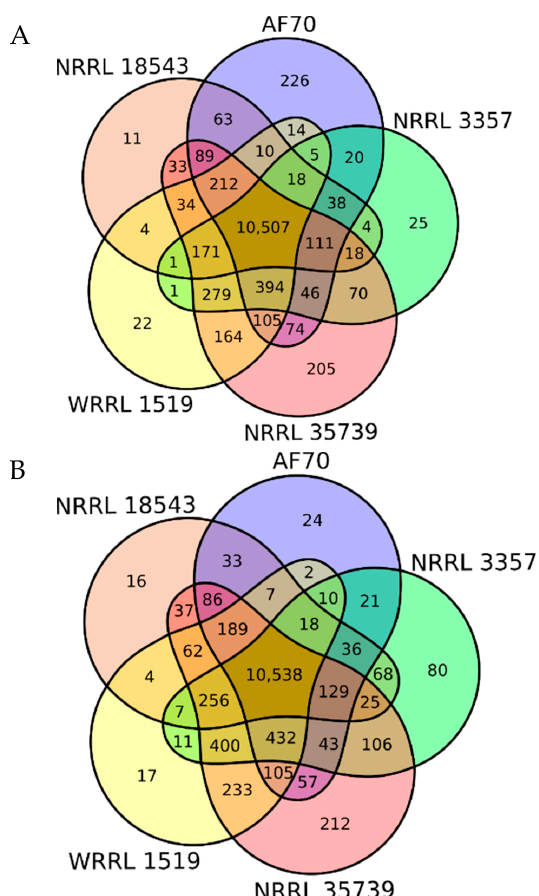
Figure 4. Venn diagrams of commonly expressed genes for selected A. flavus strains . Genes that had FPKMs greater than 0 were counted according to RNA sequence read alignment to the genomes of ( A ) AF70 or ( B ) NRRL 3357. A total of 222 AF70 genes and 221 NRRL 3357 genes were not expressed by any of the five strains and are not represented in the figure. The total number of annotated genes in the AF70 and NRRL 3357 genomes were 13,196 and 13,485, respectively.